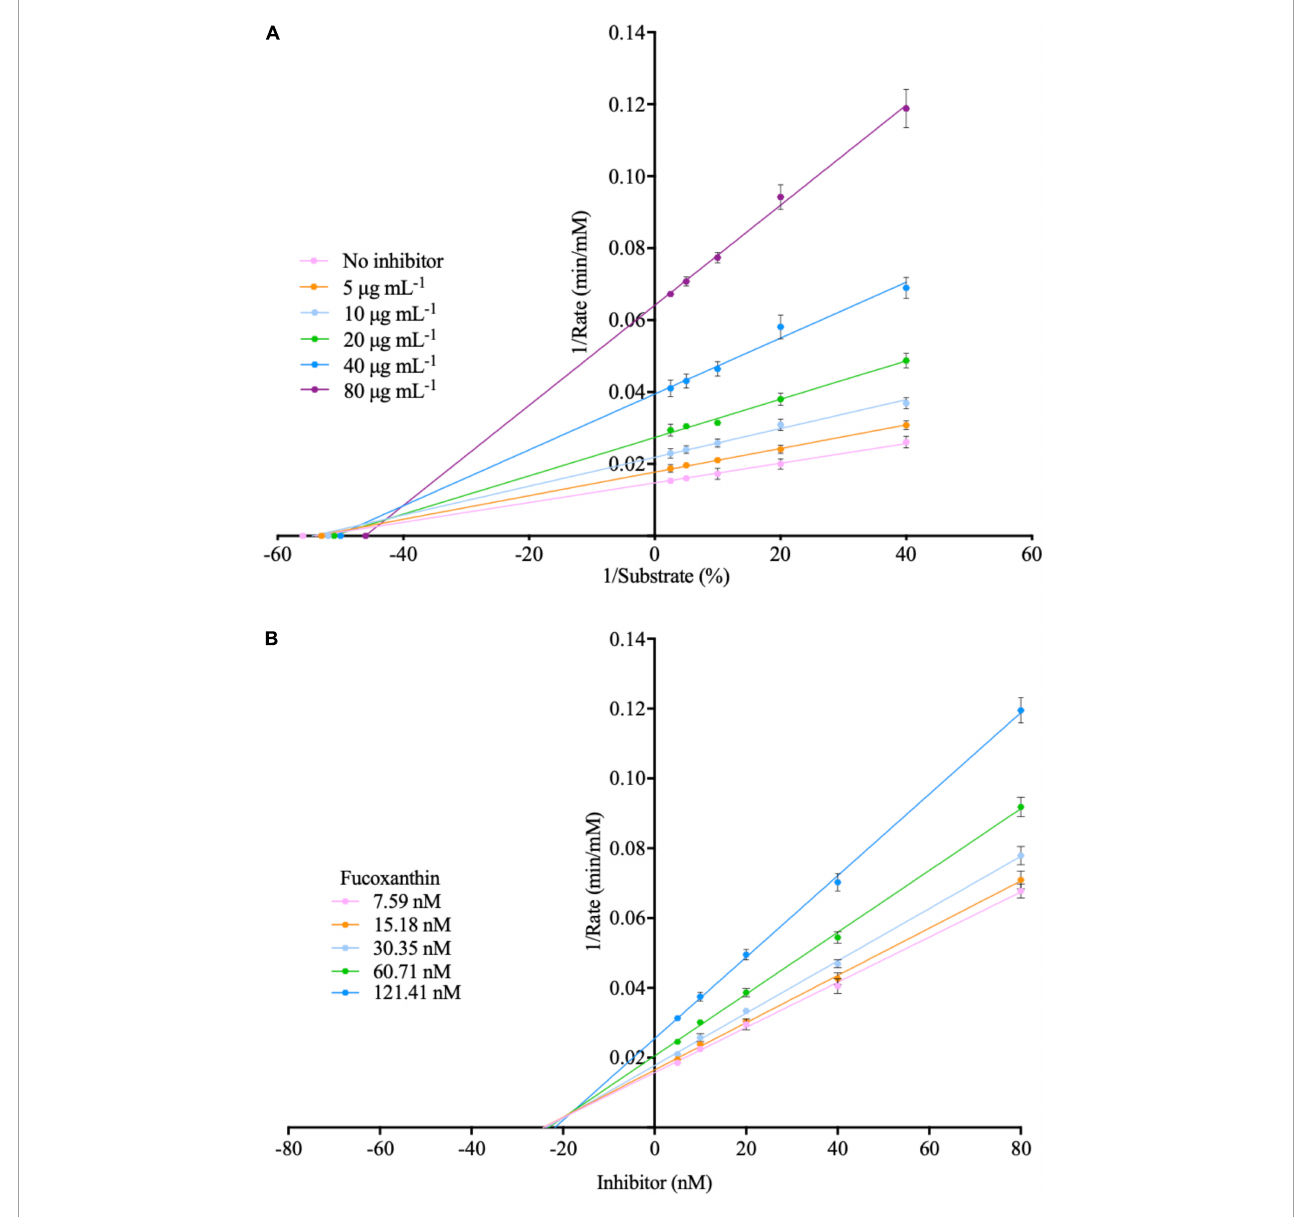
FIGURE5 (A) Lineweaver-burk plot for the inhibition of fucoxanthin inhibit α -amylase. (B) Dixon plot for the inhibition of fucoxanthin inhibit α